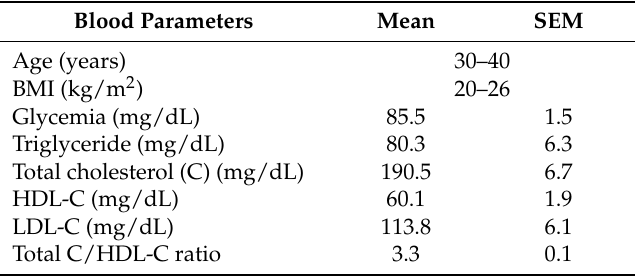
Table 3. Blood lipid parameters of the study populations: BMI = Body Mass Index; HDL-C